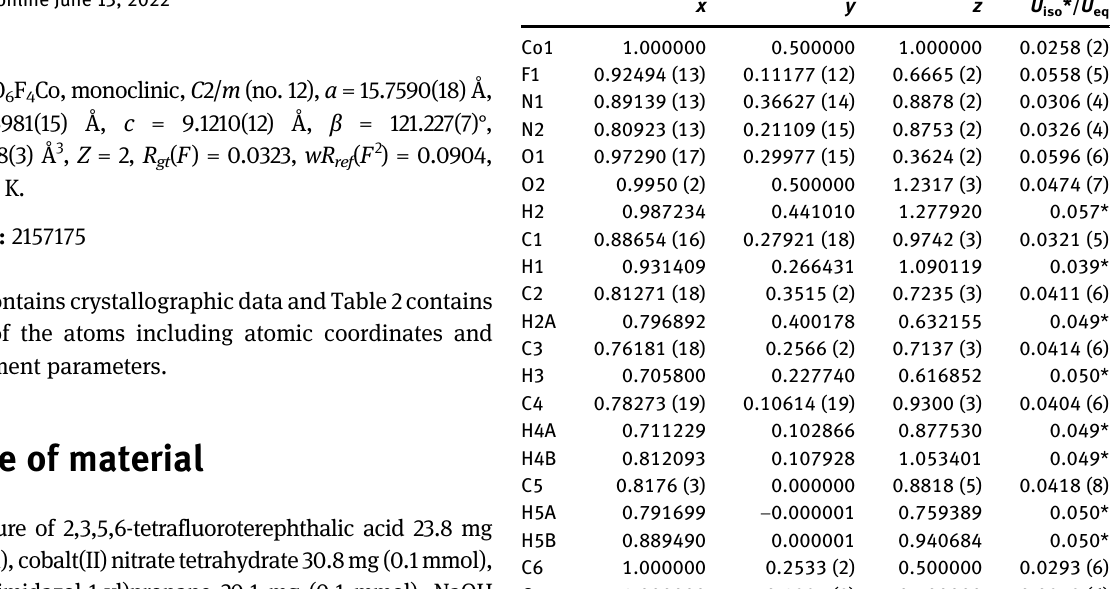
Table 1 contains crystallographic data and Table 2 contains the list of the atoms including atomic coordinates and displacement parameters.